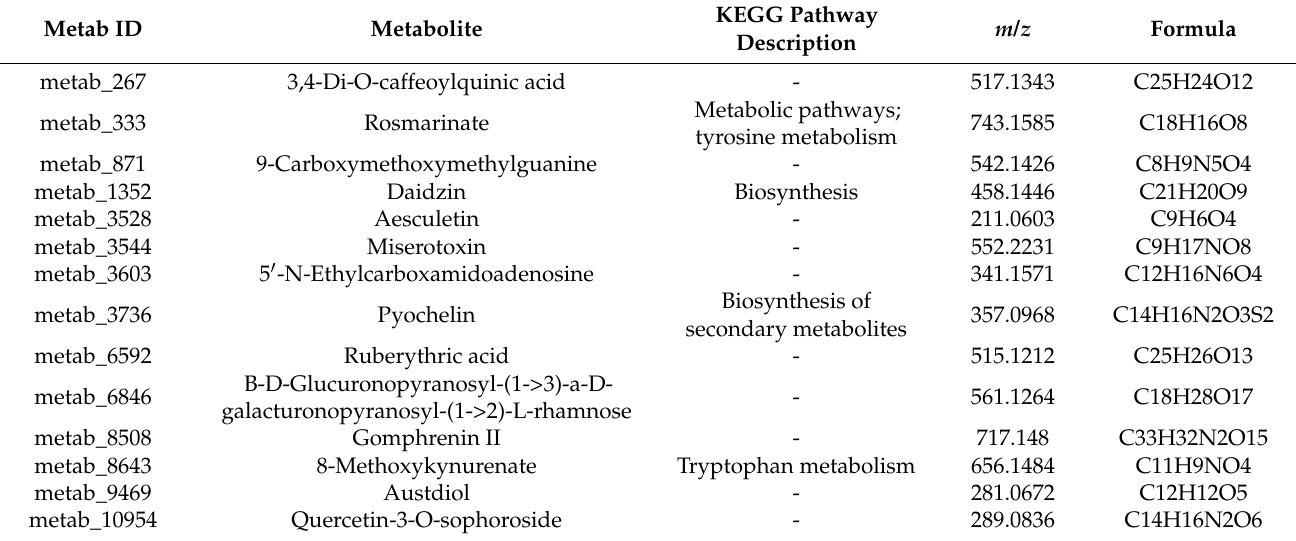
Figure 3. Metabolites number ( A ) and PCA of metabolites ( B ) in different ripening stages. In ( A ) and ( B ), the left and right panels represent positive and negative metabolites, respectively. GR, Green ripe; BR, Break; TU, Turning; MA, Mature; OM, Over-mature. Table 1. Metabolites uniquely existed in the MA stage fruits.